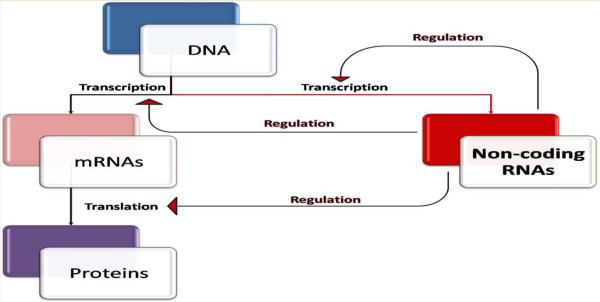
‘Modified’ central dogma. The central dogma of molecular biology states that DNA is transcribed to RNA, which is then translated into protein. In light of the emerging importance of non-coding RNAs, this diagram shows how non-coding RNAs serve to regulate each step in the central dogma, including regulating their own transcription.